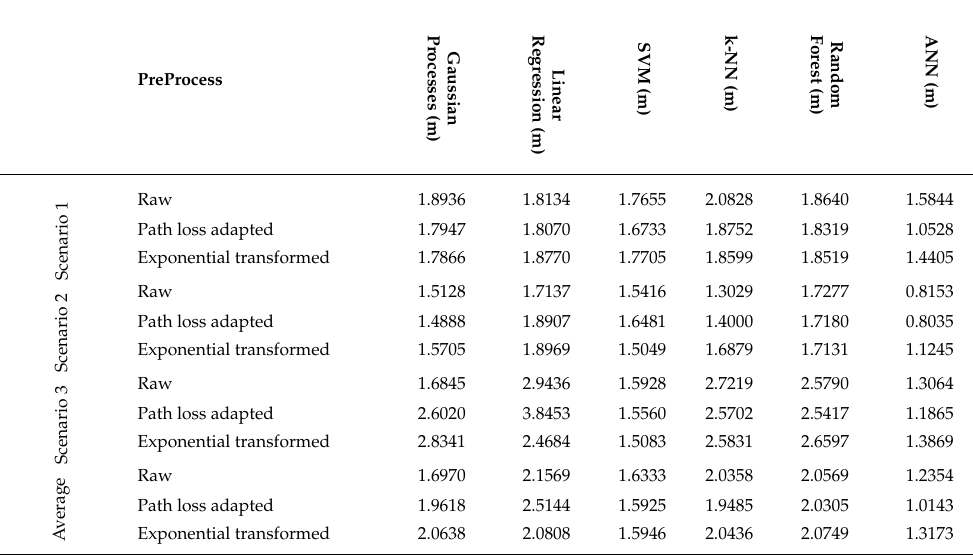
Table 6. Estimation accuracy of all methods in terms of